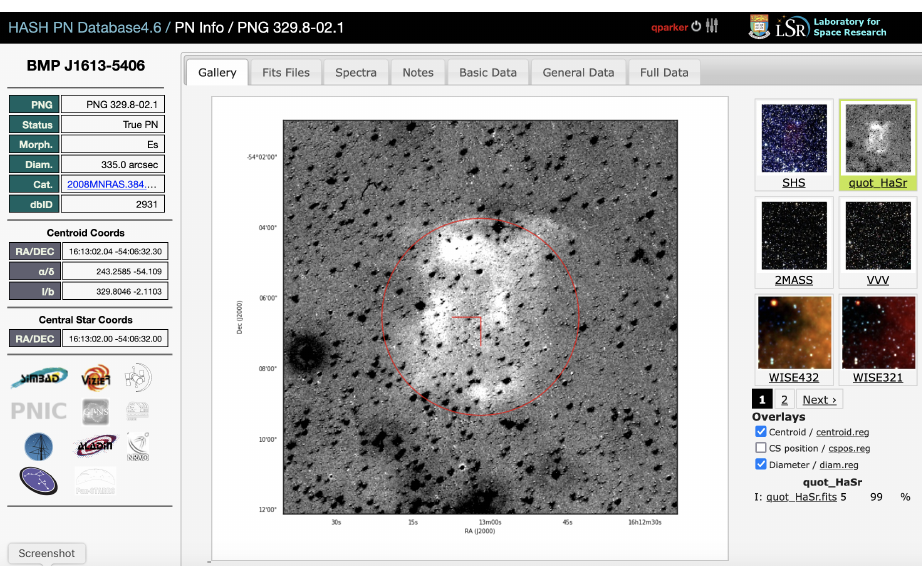
Figure 1. A 12 × 12 arcminute continuum subtracted ( H α divided by short red) SuperCOSMOS H α Survey (SHS: http://www-wfau.roe.ac.uk/sss/halpha/ (accessed on 5 February 2022)) image of the evolved bipolar PN BMP J1613-6406 and part of its host cluster NGC 6067 from the HASH (www.haspn.space (accessed on 5 February 2022)) database main image page showing various PN data and multiwavelength imagery. North is on the top East on the